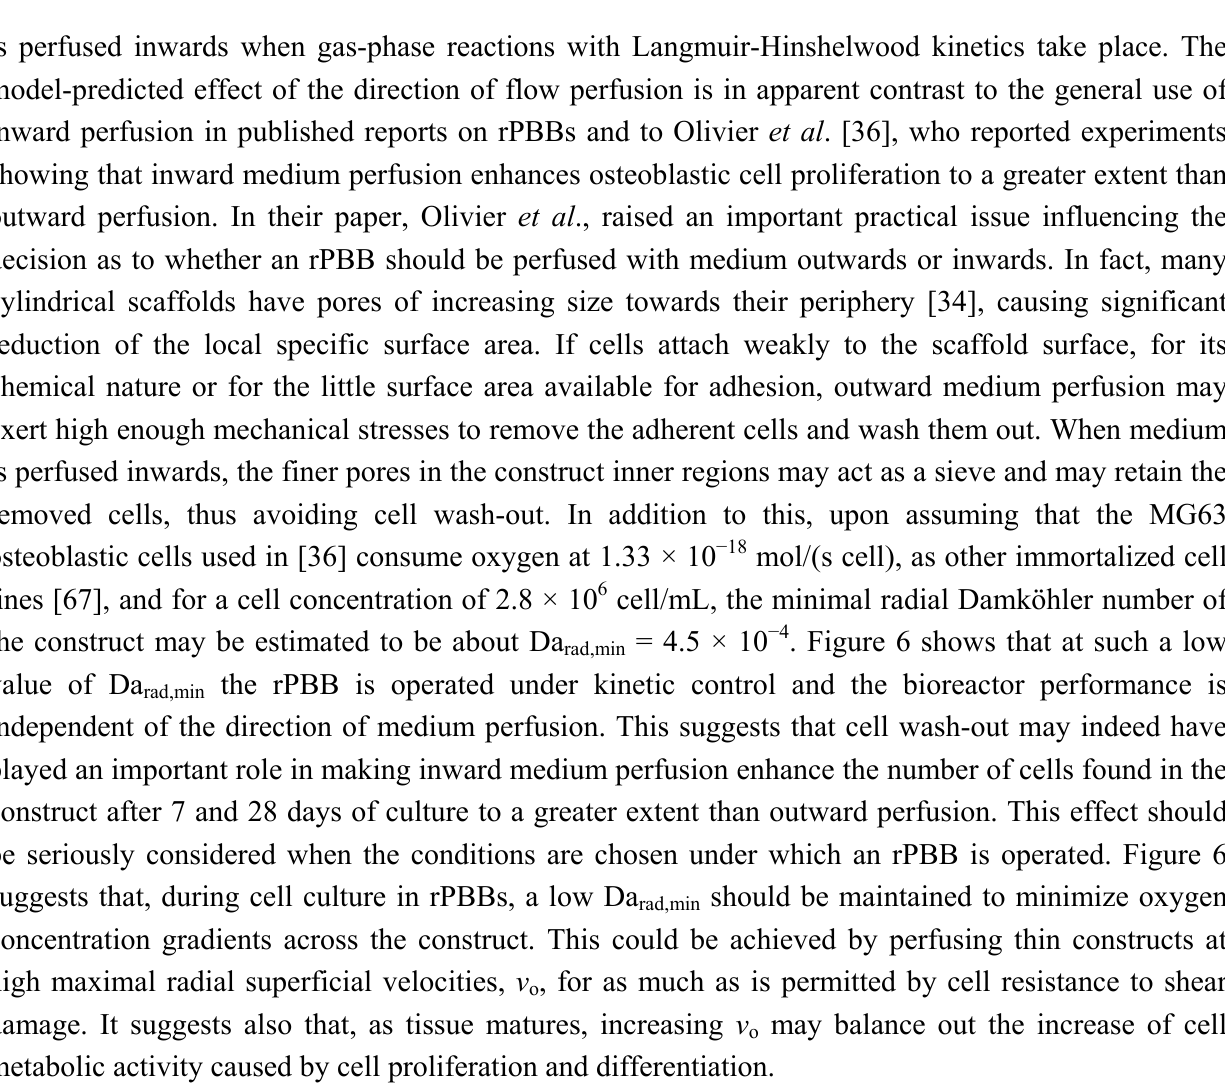
of the NHy-FCV of 3D porous hollow rad,min / δ , in an rPBB when radially i C